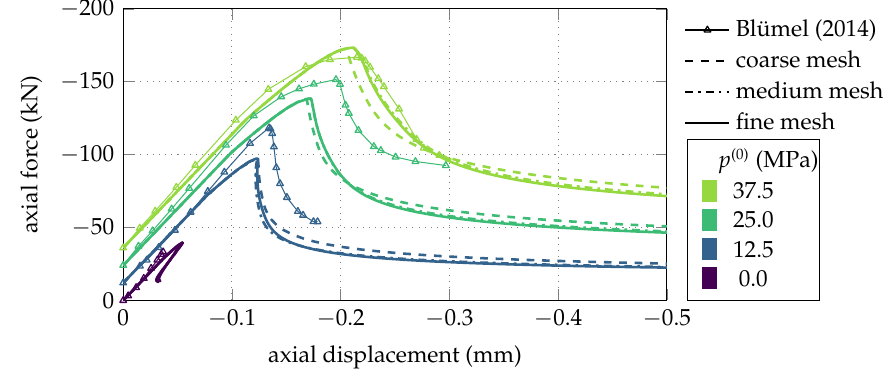
Figure 8. Load–displacement curves (axial force versus axial displacement) for triaxial compression tests: experimental and numerical results for different levels of confining pressures p (0) .